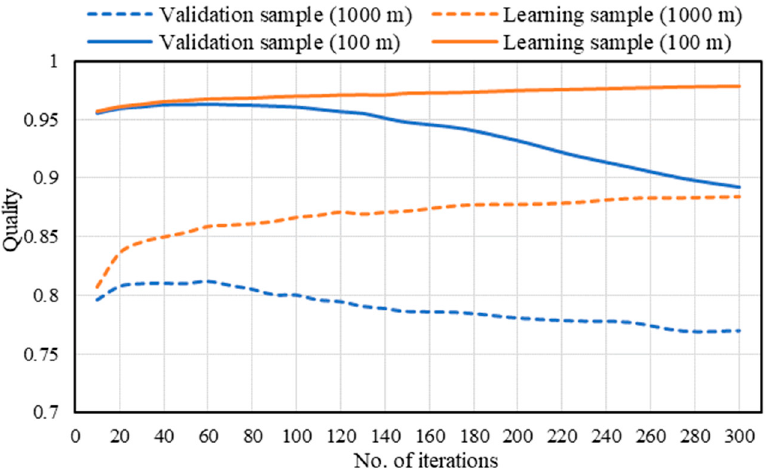
Figure 9. Average quality of the validation sample based on the number of learning iterations for two sizes of primary field.